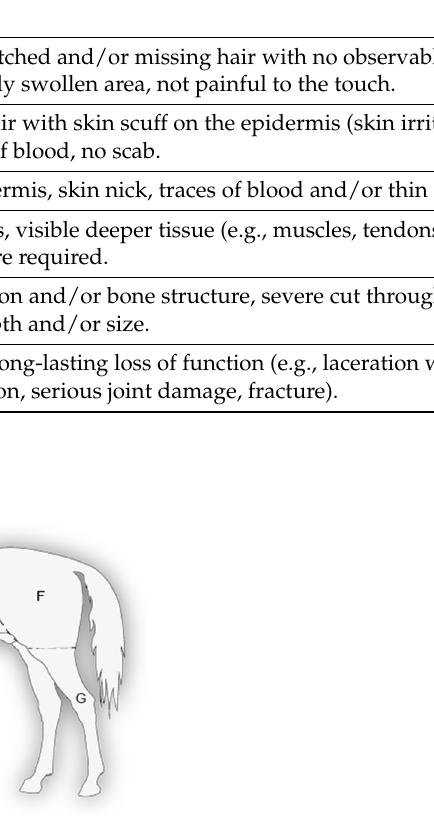
Table 2. Injury scale used to categorise the severity of the injuries, adapted from [33–36]. The presence or absence of blood or scab was the main factor used to categorise injuries.